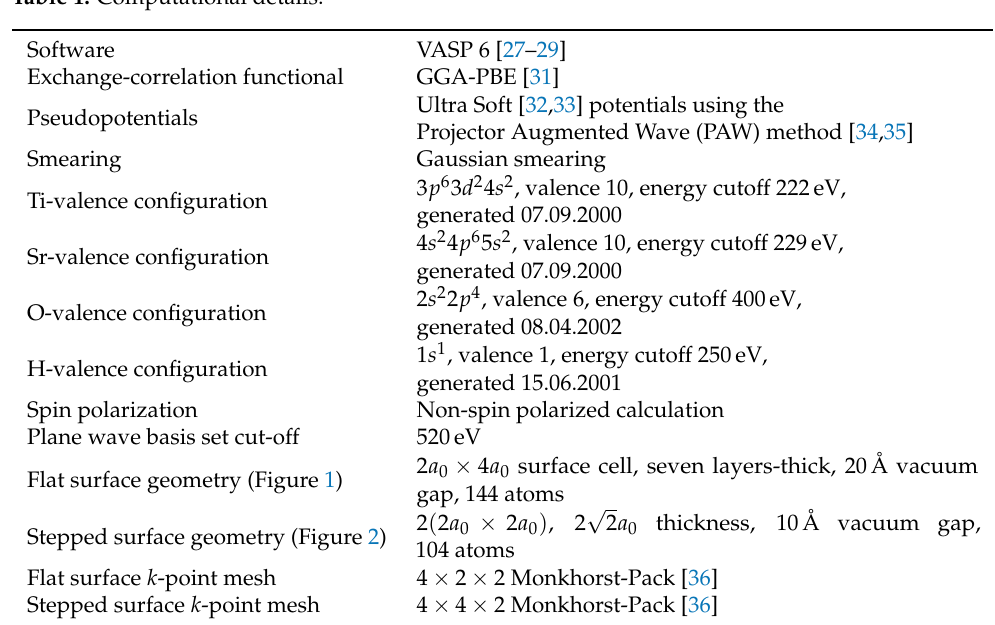
Table 1. Computational